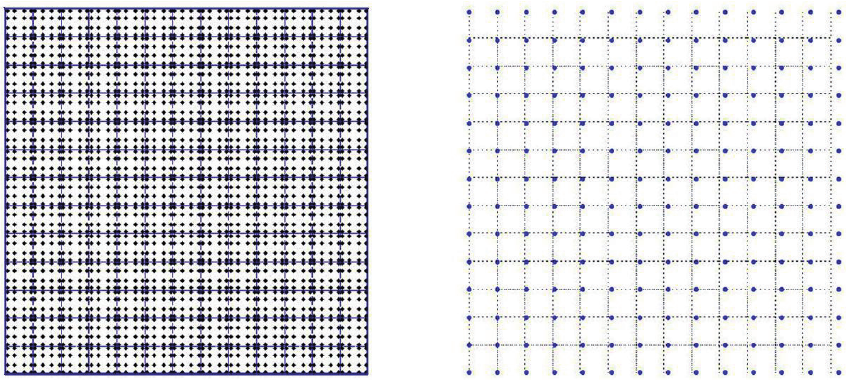
Fig. 3. Gauss points and deformed configuration of laminated composite plate.